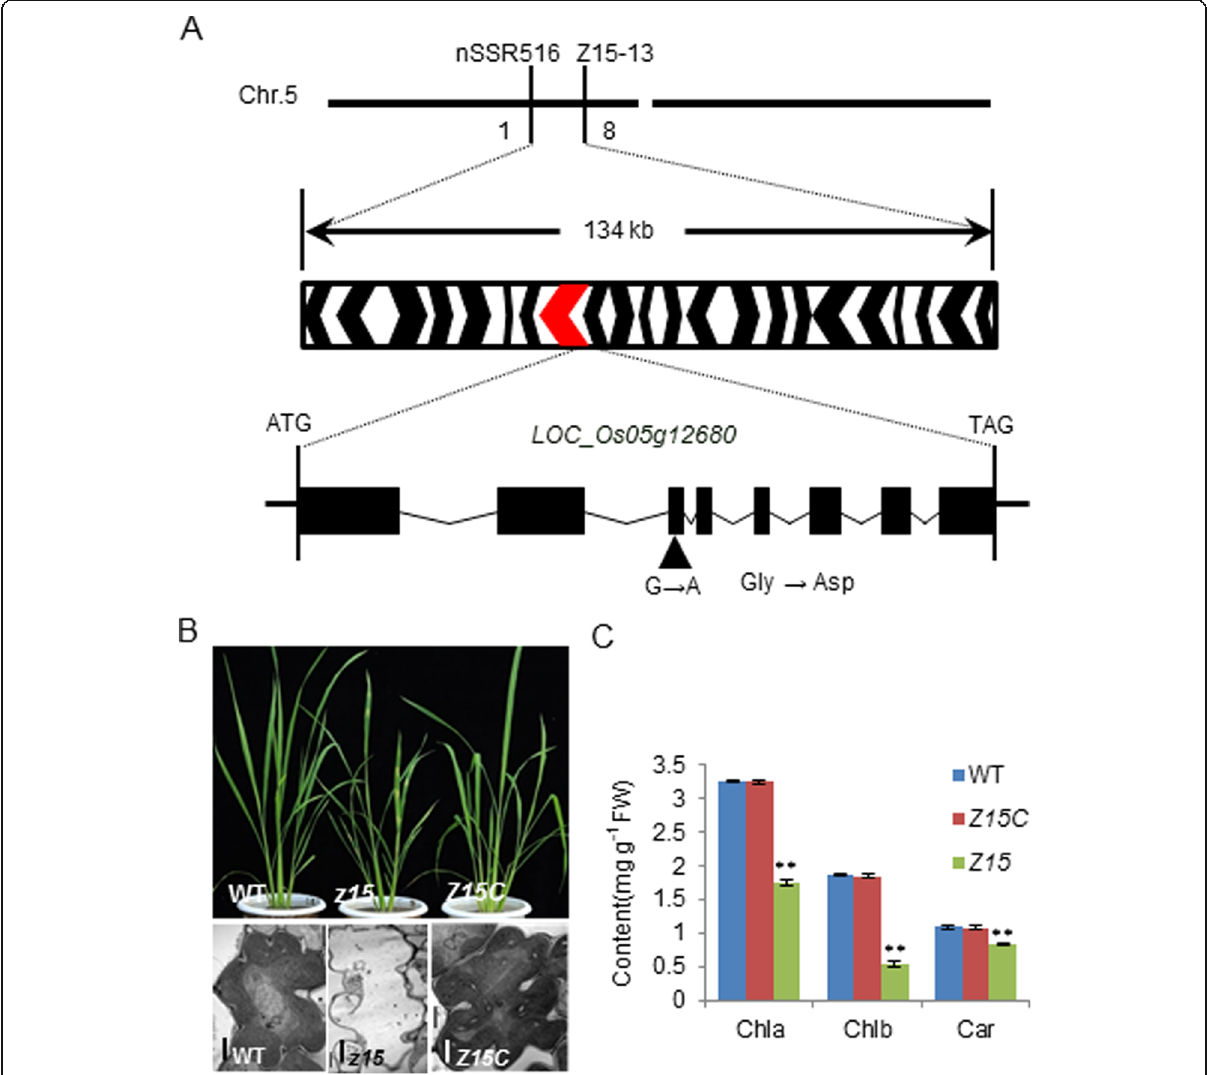
Fig. 2 Molecular identity of Z15 . a Map-based cloning of the Z15 gene. b Phenotypes of the wild type (WT), z15 mutant, complemented transformant (com). c Chlorophyll contents of the leaves of the wild type, complemented transformant (Z15C), and z 15 mutant plants at the tiller stage. Bars: (B) =2 μ